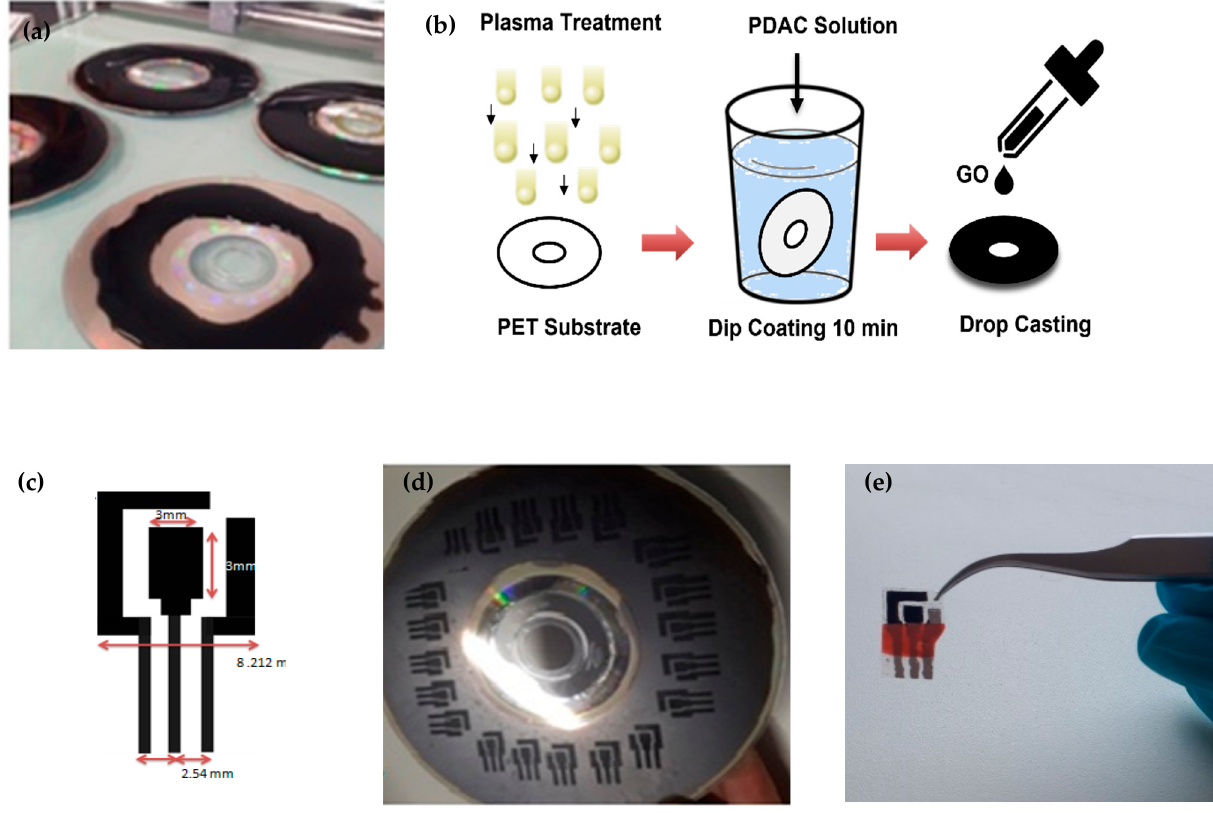
Figure 1. Illustration of the fabrication process of LRGO electrodes: ( a ) PET substrate coated with the GO film; ( b ) PET/plasma/PDAC process; ( c ) individual three-electrode configuration structure designed with Inkscape software; ( d ) substrate containing a set of individual electrodes; ( e ) finished LRGO device.